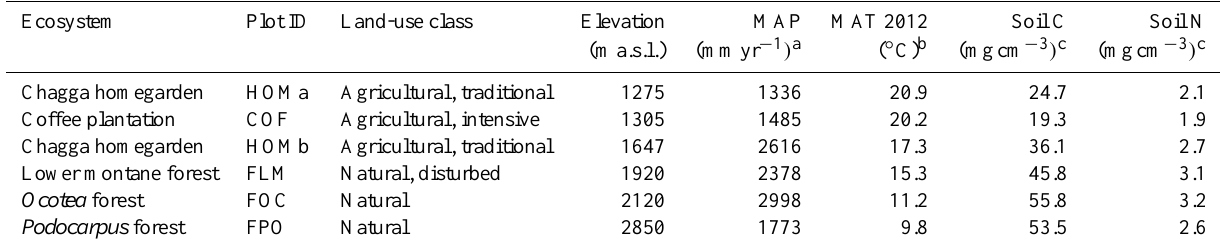
Table 1. Land-use classification, topographic and climatic information and C and N stocks in 0–10cm soil depth of research plots on the southern slope of Mt. Kilimanjaro. Ecosystem Plot ID Land-use class